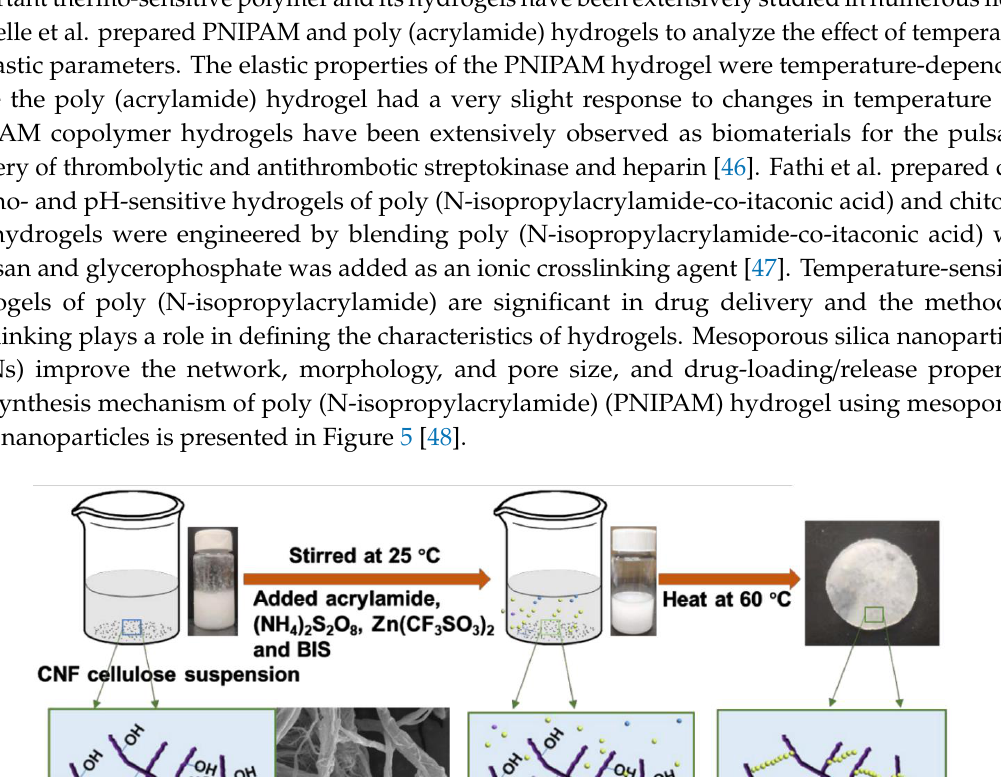
Figure 3. Preparation of vinyl hybrid silica nanoparticles (VSNPs) from vinyl-triethoxysilane nanoparticles followed by the synthesis of VSNP-PAM from VSNPs (crosslinking agent), ammonium